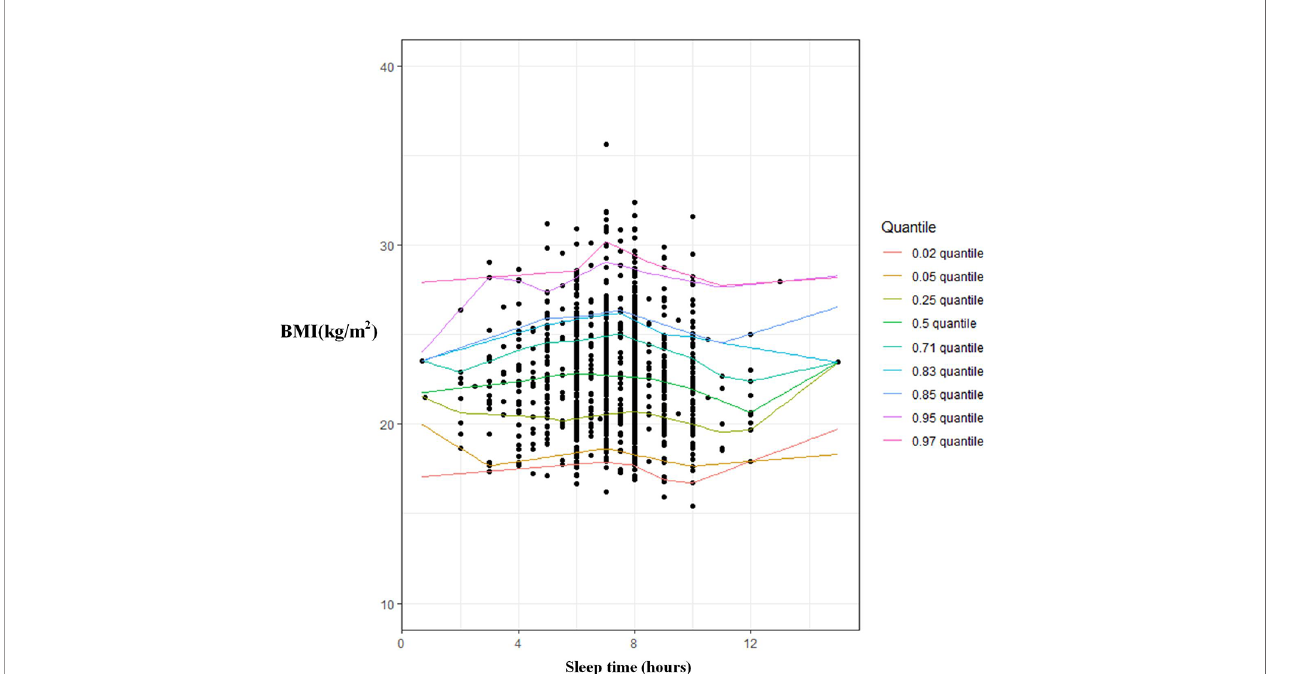
FIGURE 1 | The association between sleep duration and BMI among men using multivariate quantitle regression model.